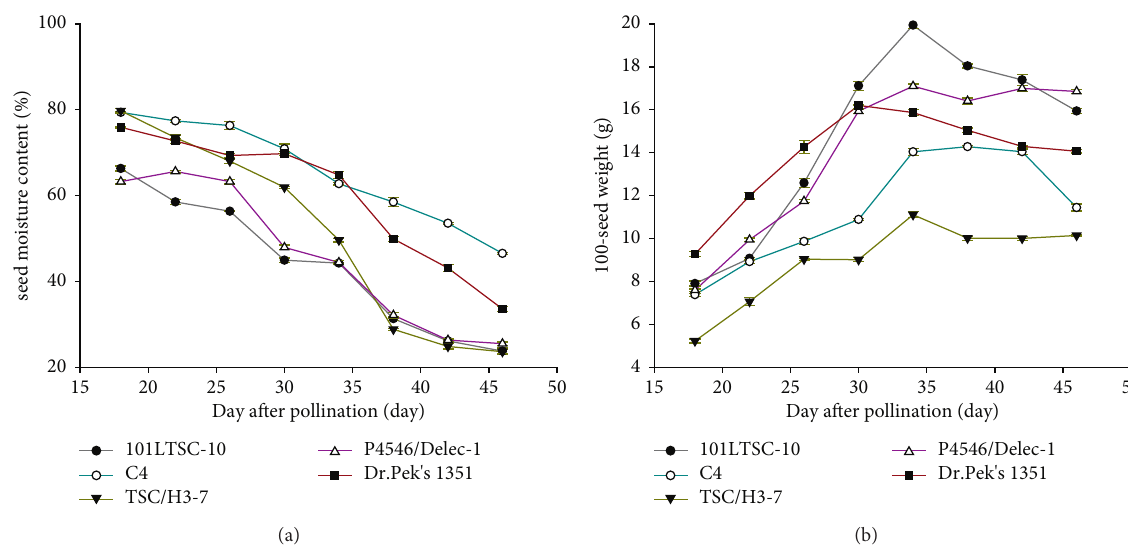
Figure 1: The changes of seed physical parameters during seed developments of sweet corn: (a) seed moisture content and (b) 100-seed dry weight. The data are means of four replicate samples and error bar ± SD ( n �